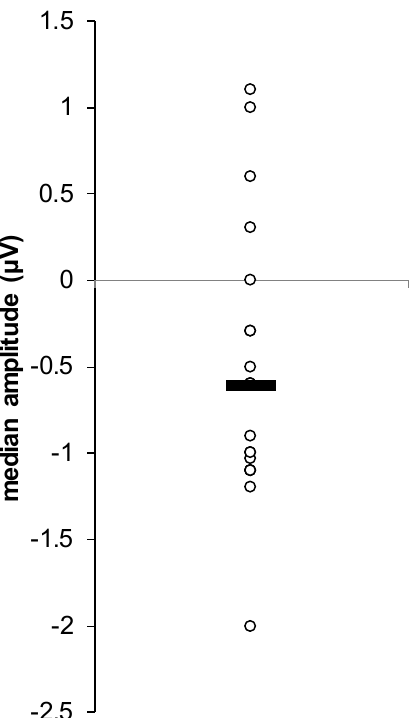
Figure 5. Individual differences between baseline and early-post tetanus. The “black line” shows the median difference.